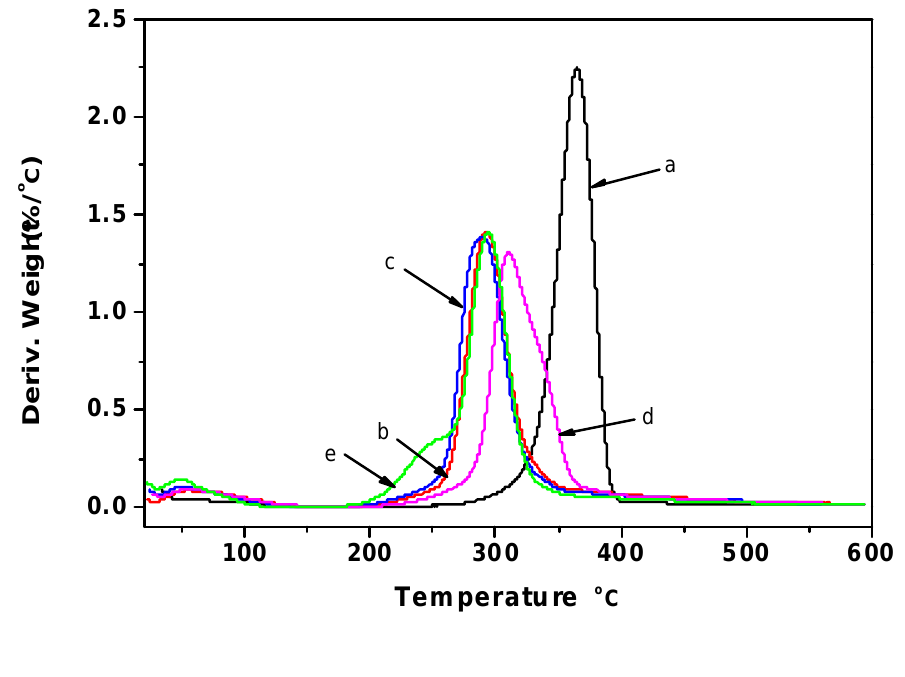
Figure 6. The differential thermal analysis (DTA) curves of samples: ( a ) cotton linter; ( b ) control sample; ( c ) cellulose film plasticized with sorbitol; ( d ) cellulose film plasticized with glycerol; ( e ) cellulose film plasticized with